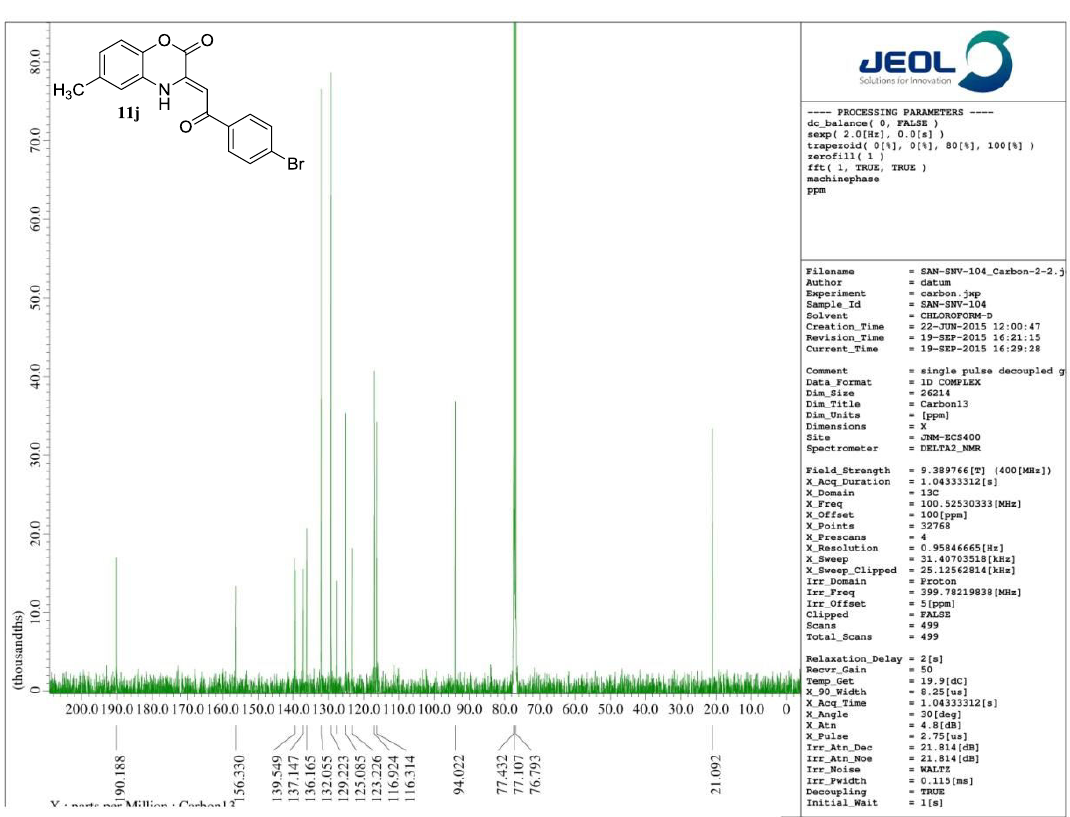
Figure 20. 13 C NMR Spectra of Compound 11j